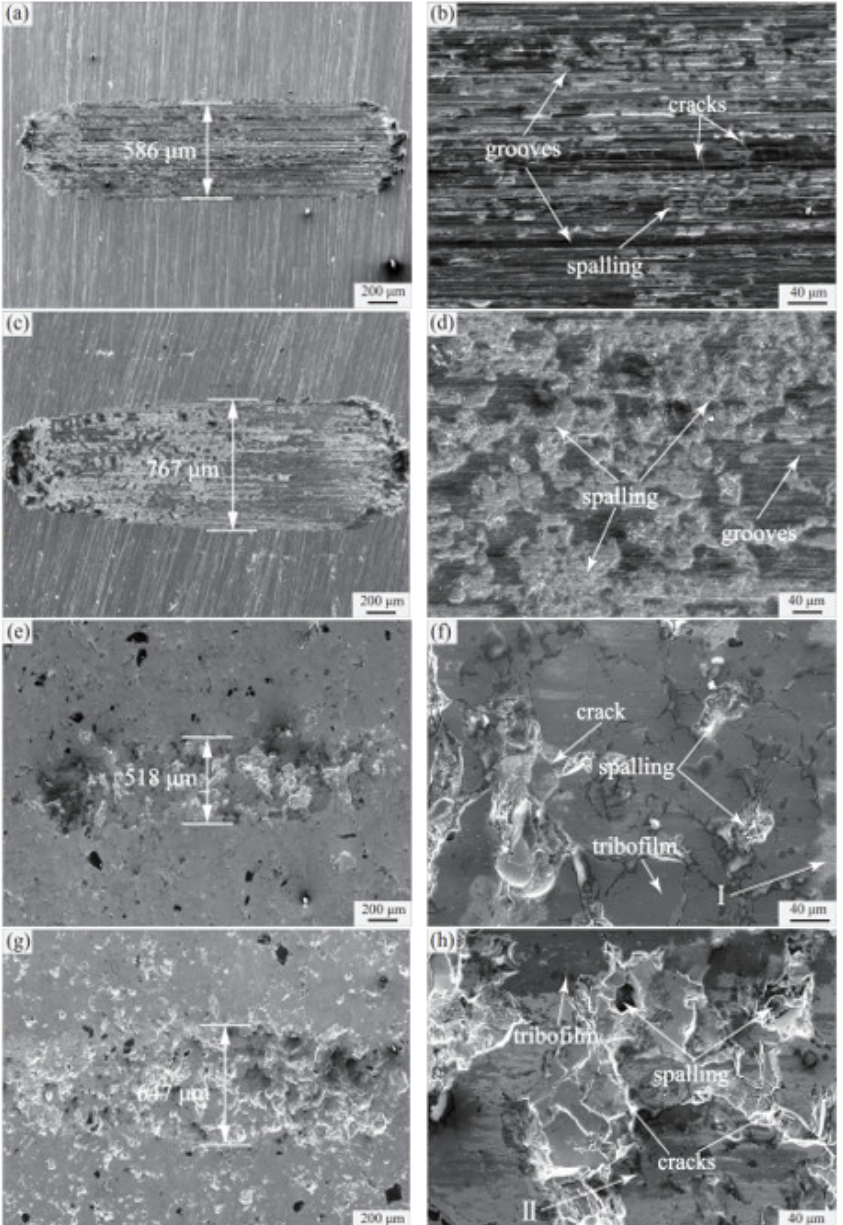
Figure 11. Micromorphology of wear scars of low-carbon steel and coating at sliding speeds of 500 t/min and1000 t/min ( a , b ) low-carbon steel, 500 t/min; ( c , d ) low-carbon steel, 1000 t/min; ( e , f ) Fe-based-Al 2 O 3 -B 4 C, 500 t/min; ( g , h ) Fe-based-Al 2 O 3 -B 4 C, 1000 t/min. Table 9. The results of EDS in different areas (wt. %).